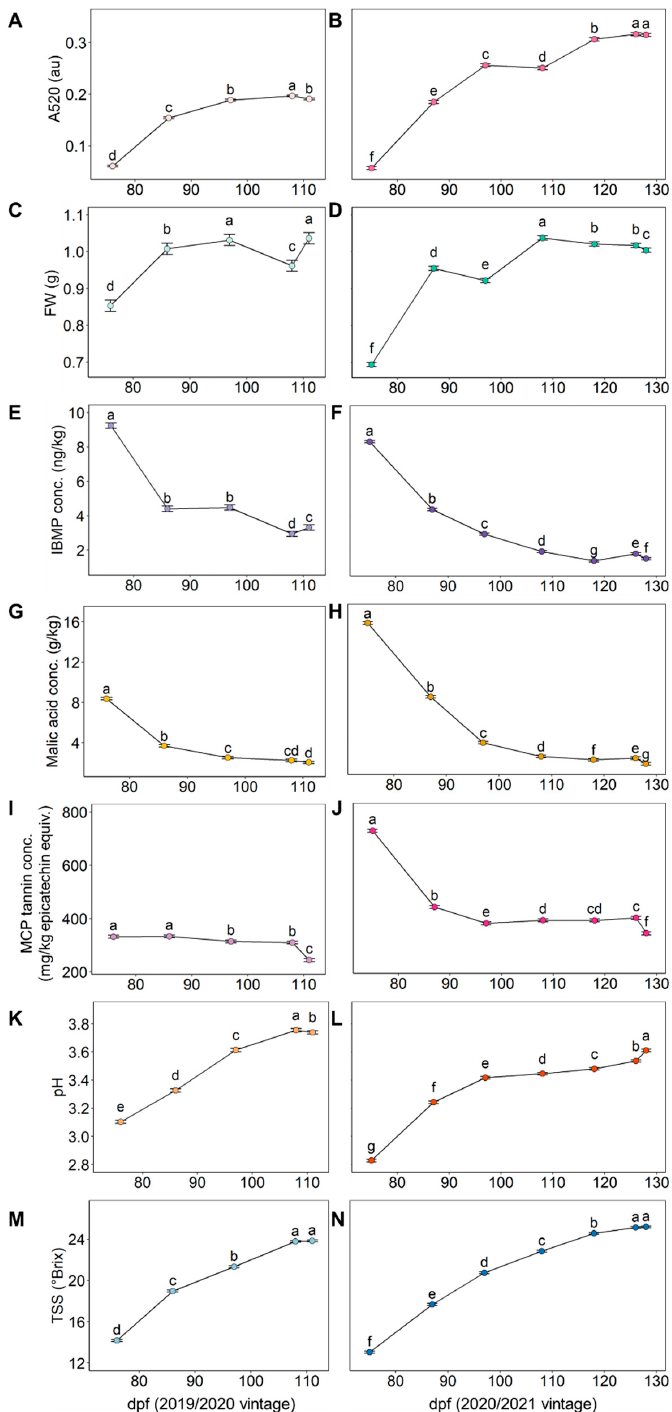
Figure 2. Changes between sampling dates (days post-flowering, dpf) in the average values of ( A , B ) absorbance at 520 nm (A520), ( C , D ) berry fresh weight (FW), ( E , F ) 3-isobutyl-2-methoxypyrazine (IBMP) concentration, ( G , H ) malic acid concentration, ( I , J ) methyl cellulose precipitable (MCP) tannin concentration, ( K , L ) pH, and ( M , N ) total soluble solids (TSS) over the 2019/2020 ( A , C , E , etc.) and 2020/2021 ( B , D , F , etc.) seasons according to mean ± SEM ( n = 24 vines per sampling date). Different lower-case letters within a vintage for a given measurement represent significant differences between sample date (linear mixed model, α = 0.05, Bonferroni-adjusted).